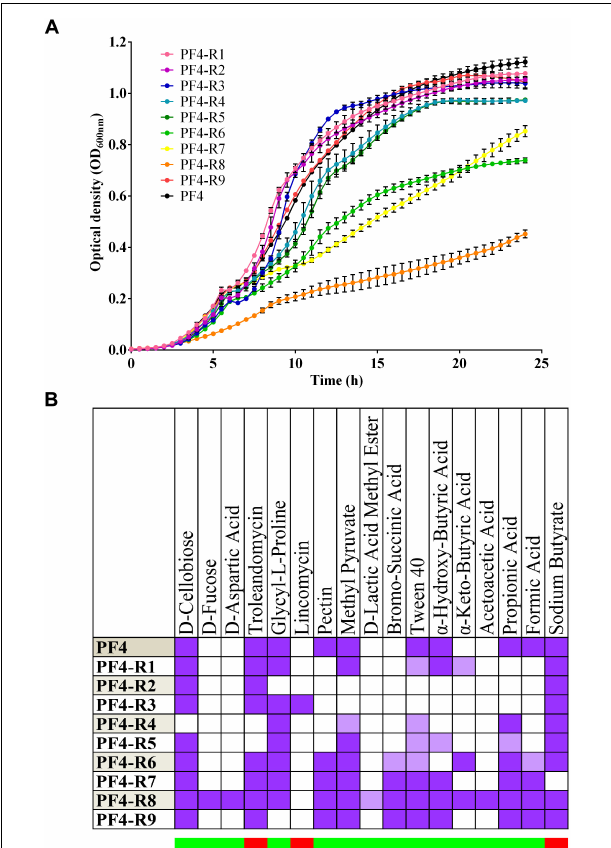
FIGURE 1 | Phenotypic diversity of V. anguillarum strains resistant to the CHOED phage. (A) Growth curve of bacteriophage-resistant V. anguillarum strains. PF4 is the wt parental strain. The error bars indicate standard deviation. The cultures were performed in quadruplicate. (B) Differences in biochemical profile of bacteriophage-resistant V. anguillarum strains. Differences observed in biochemical profile among the different strains using BIOLOG GEN III MICROPLATETM. PF4 is the wt parental strain. The upper part shows the different chemical compounds used in the corresponding test. The purple color indicates a positive reaction (growth), white indicates a negative reaction (no growth) and light purple indicates an intermediate reaction. The lower bar indicates whether it is a test for susceptibility to the compound (red) or for its use as a source of carbon (green).